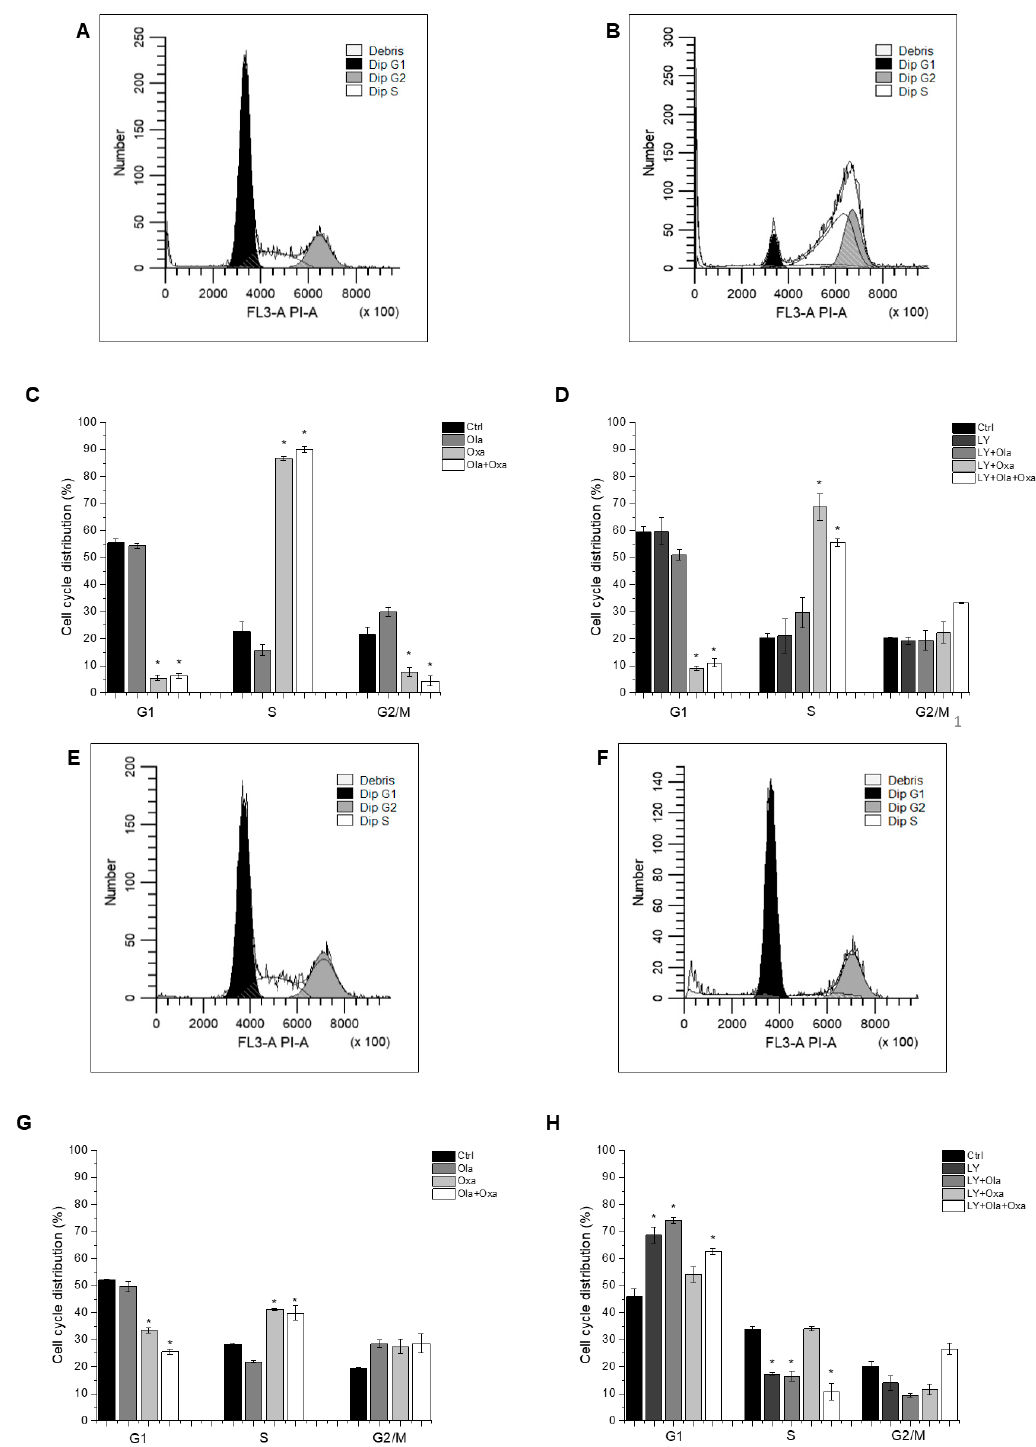
Figure 4. Flow cytometry analysis of MDA-MB-231 ( A – D ) and MCF7 ( E – H ) cell-cycle distribution. Cells were cultured and treated for 72 h with 2 µM olaparib, 25 µM oxaliplatin and 1 µM LY294002 alone and in combination. The cell-cycle distribution was determined with propidium iodide staining. The histograms show cell-cycle phases of control cells ( A , E ) and cells treated with combination of olaparib, oxaliplatin and LY294002 ( B , F ). The bar charts represent effect of single and combined treatment on cell cycle phase distribution ( C , D , G , H ). Results are expressed as mean ± SEM of at least three separate experiments. * p < 0.05 compared with the untreated cells.